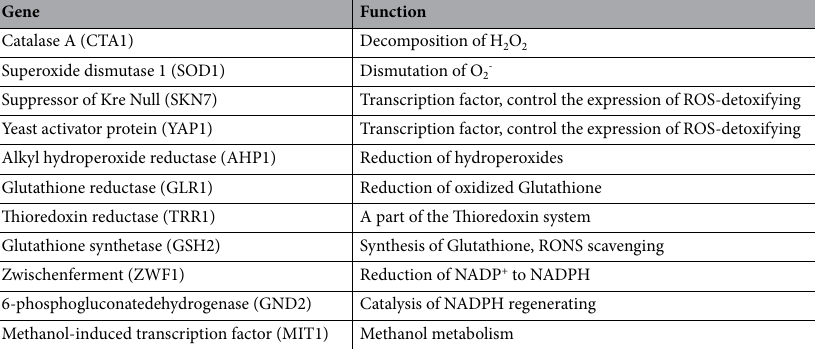
Table 1. The studied genes for evaluation of expression by real-time